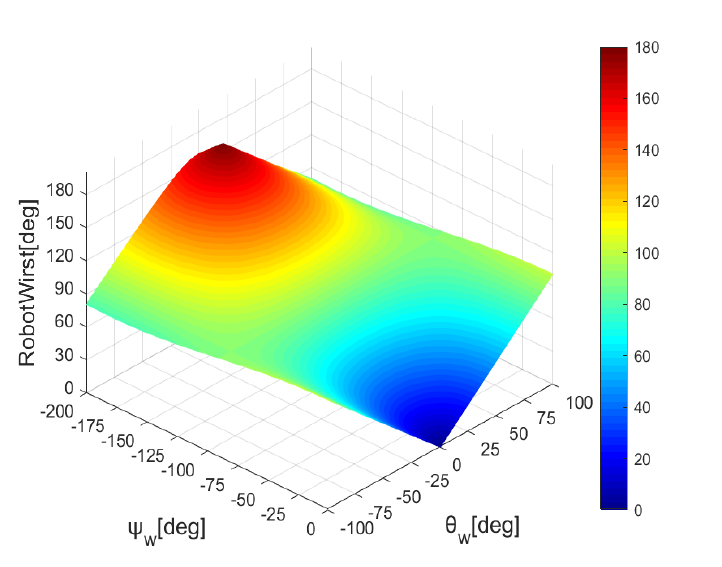
Figure 9. Wrist joint angle map.